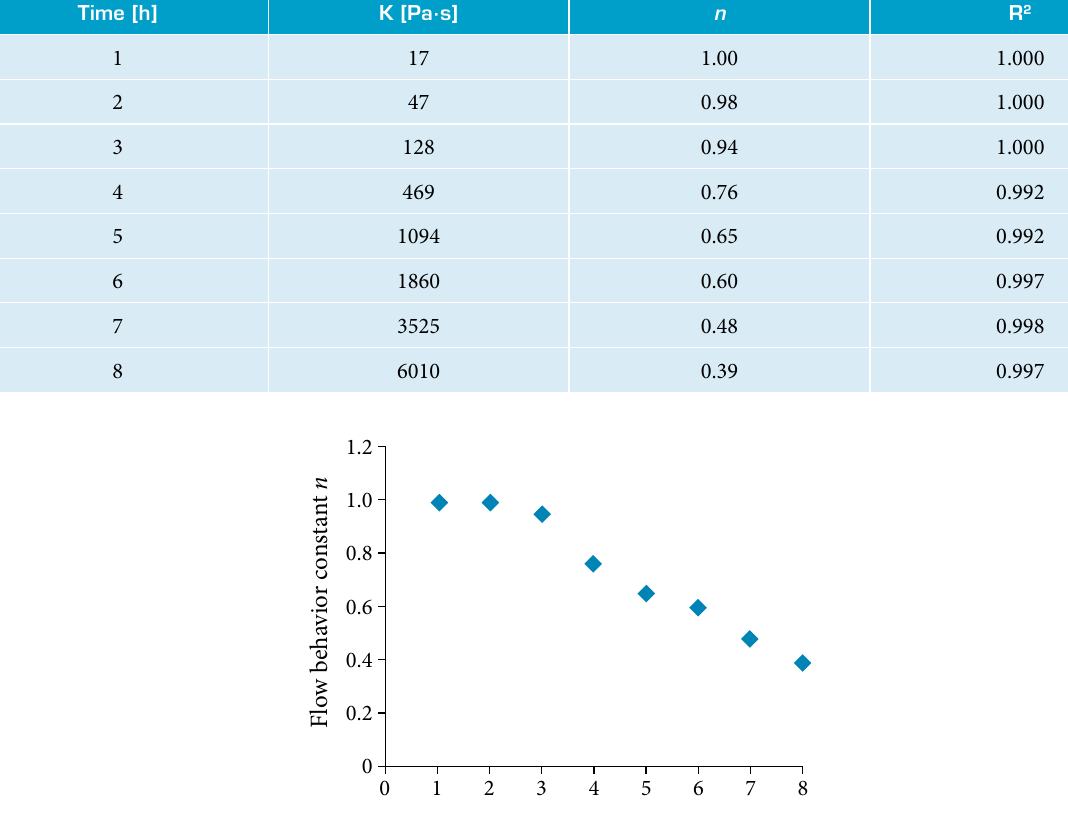
Figure 2. Variation in viscosity of the liner with shear rate. Table 1. Values of flow consistency and flow behavior constants.